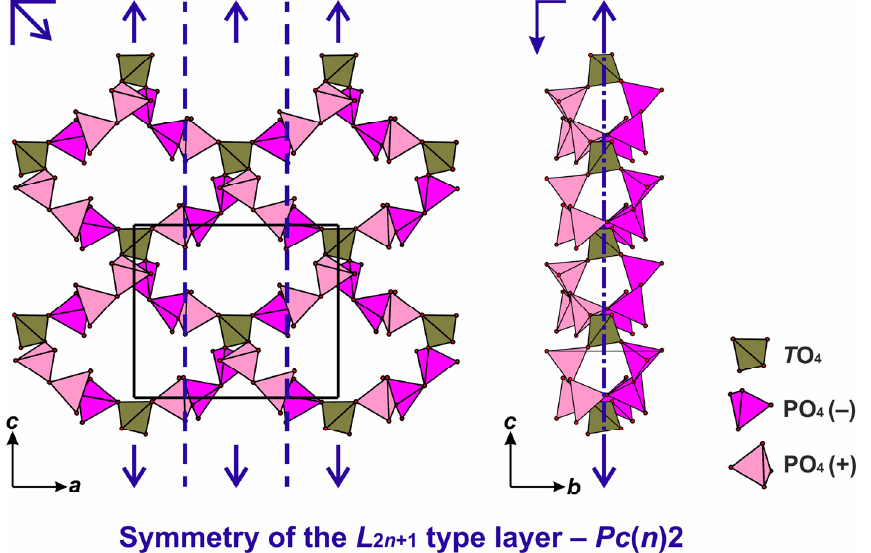
Figure 1. The general view of the tetrahedral L 2 n +1 type layer in the crystal structures of Cs{ [6] Al 2 [ [4] T P 6 O 20 ]} polytypes. The fundamental building block (FBB) of the layer is represented by